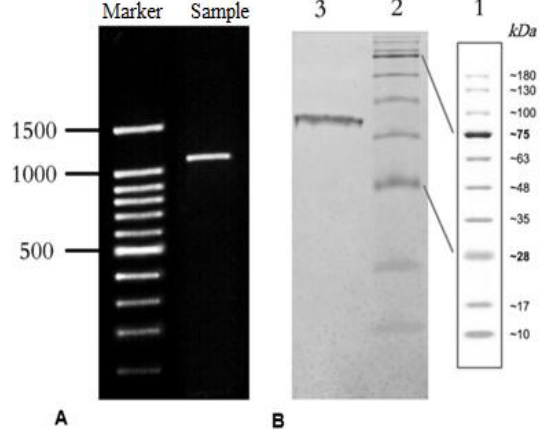
Fig. 4. Colony PCR (Polymerase Chain Reaction) and sodium dodecyl sulfate-polyacrylamide gel electrophoresis (SDS-PAGE) analysis of the recombinant P. aeruginosa AlgL protein. A) PCR product of recombinant plasmid. B) Purified recombinant enzyme; 1 and 2 are molecular mass markers; 3 is the eluted protein from immobilized metal affinity chromatography (IMAC)